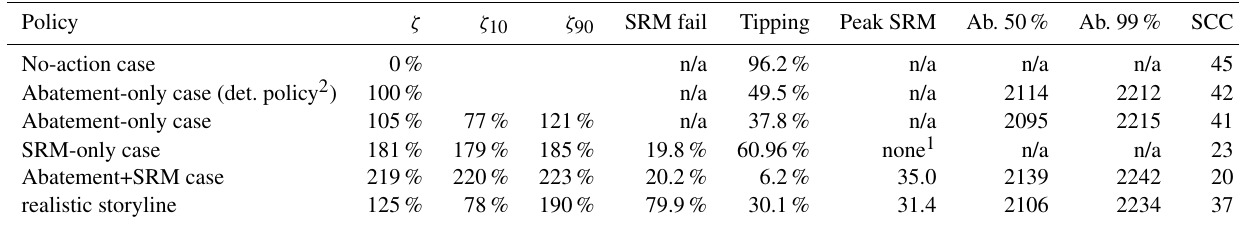
Table 3. Comparison of policies in the stochastic setting, i.e. including climate tipping and SRM failure. No-action case means that neither abatement nor SRM are used; other scenarios are explained in Sect. 2.3. The performance measures ζ , ζ 10 , and ζ 90 are given in Eqs. (13) and (14). The columns “SRM fail” and “Tipping” show the probability that SRM failure or climate tipping occurs before 2415. The column “Peak SRM” contains the highest SRM value (in Mt(S)yr − 1 ) over all time steps and over all ensemble members. This corresponds to members in which no SRM failure or climate tipping occurred, at least before the time of the SRM peak. “Ab 50%” and “Ab 99%” show the year in which the abatement reaches 50% and 99%, respectively. SCC is the social cost of carbon in the first time step (measured in USD (in 2005) per tonne of